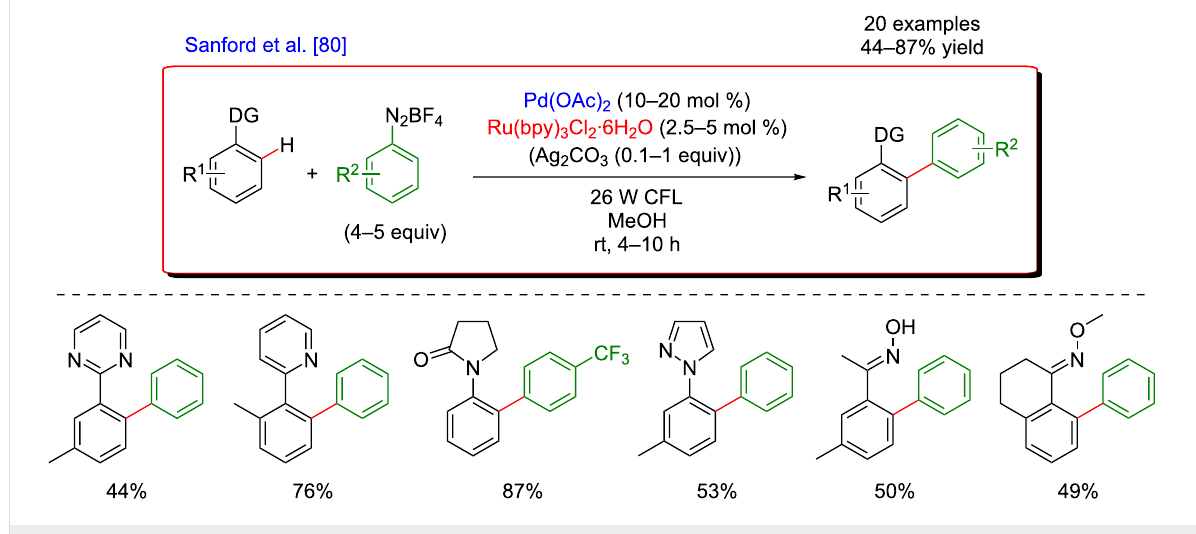
Figure 20: The first example of dual catalysis merging C–H activation and photoredox